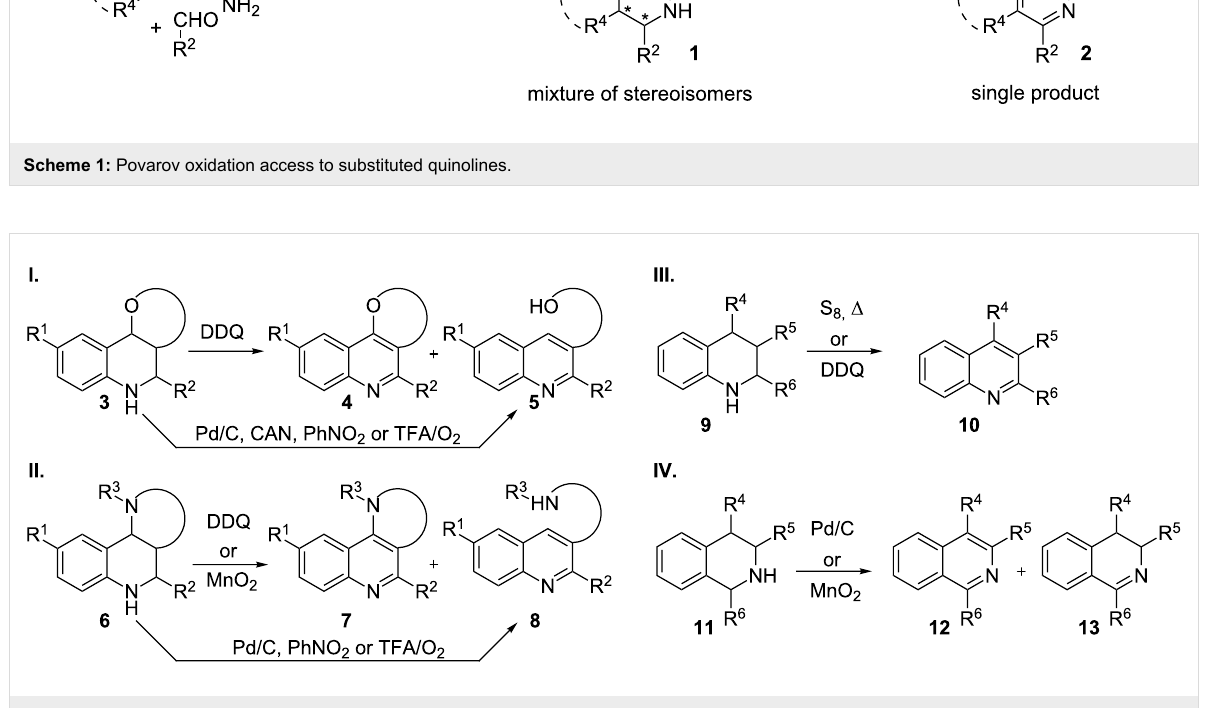
Scheme 2: Tetrahydroquinoline